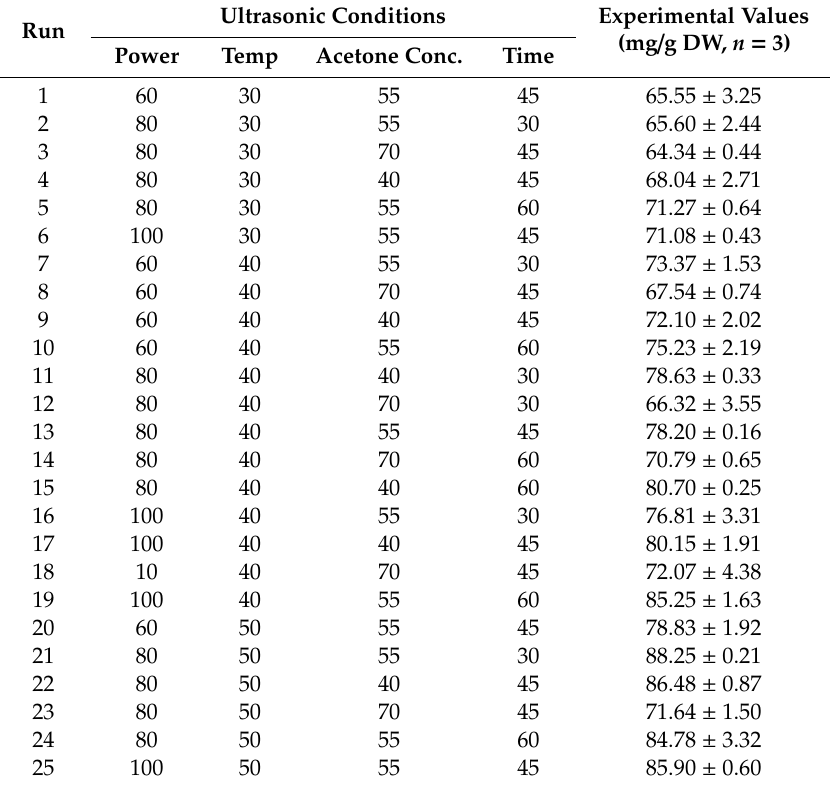
Table 1. Box-Behnken design and experimental